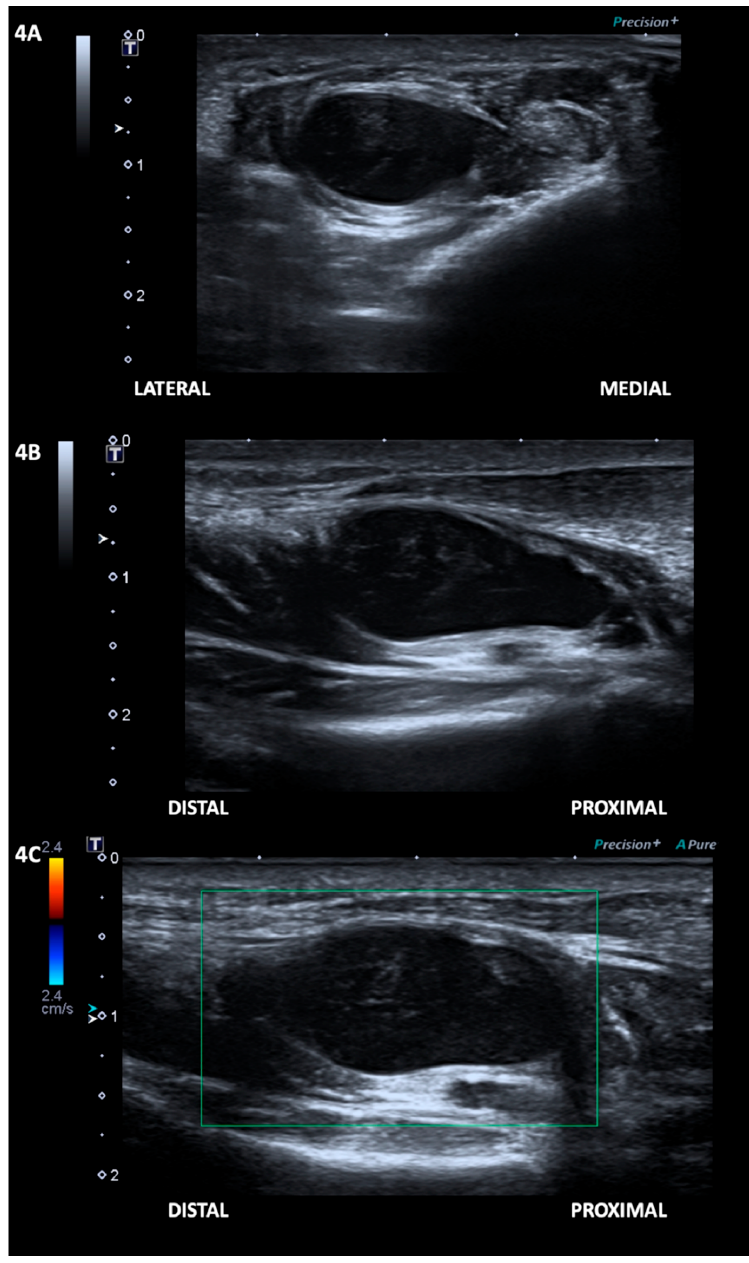
Figure 4. The second ultrasound examination revealed an anechoic defect in the mid-portion of the flexor hallucis brevis muscle, filled with a well-defined, unilocular, anechoic mass with posterior acoustic enhancement, seen in the transverse ( A ) and longitudinal ( B ) axis. Colour Doppler was negative ( C ). The appearance was compatible with a ganglion